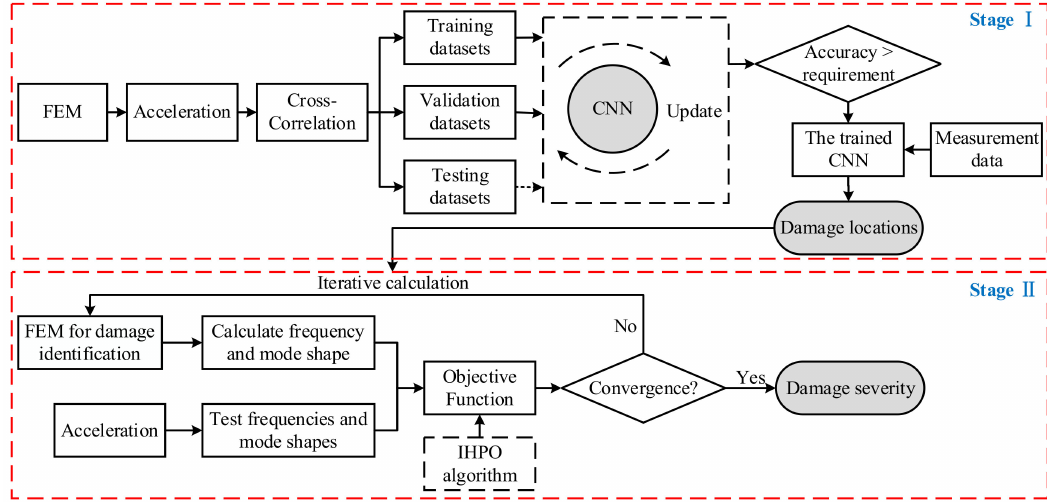
Figure 4. The flowchart of damage